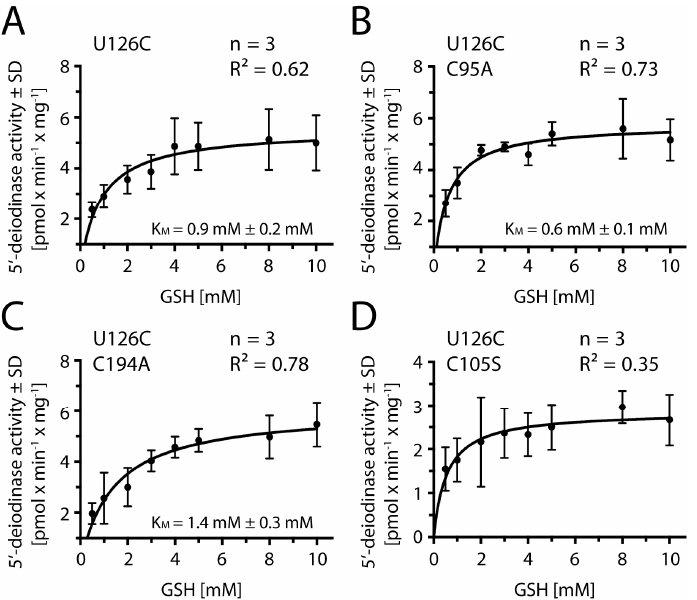
Figure A3. Kinetic analysis of human DIO1 U126C in insect cells. Michaelis constants (K M ) for GSH do not depend on cysteines 95, 105, or 194. ( A ). DIO1 U126C . ( B ). DIO1 U126C/C95A . ( C ). DIO1 U126C/C194A . ( D ). DIO1 U126C/C105S . Experiment performed in triplicates. Correlation coefficients of fits (R 2 ) and K M ± SD are indicated. Curve fitting was performed with GraphPad Prism. SD: standard deviation.